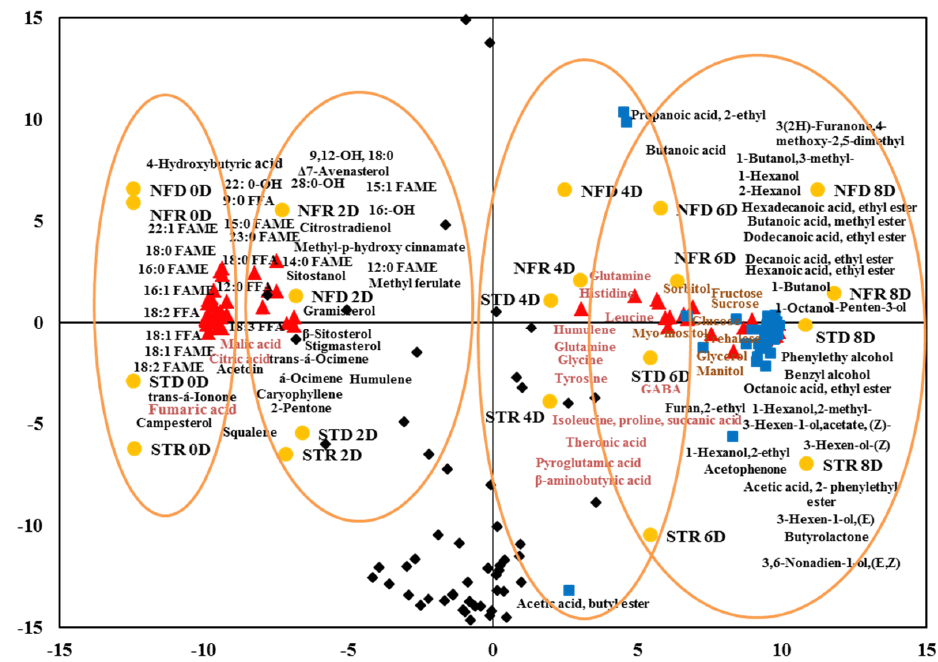
Figure 7. Principal component analysis (Biplot) from all metabolites ( ) and volatile organic com- pounds ( ), unknown metabolites and volatiles ( ) in ‘Nam Dok Mai’ mango cultivars (STD, dry